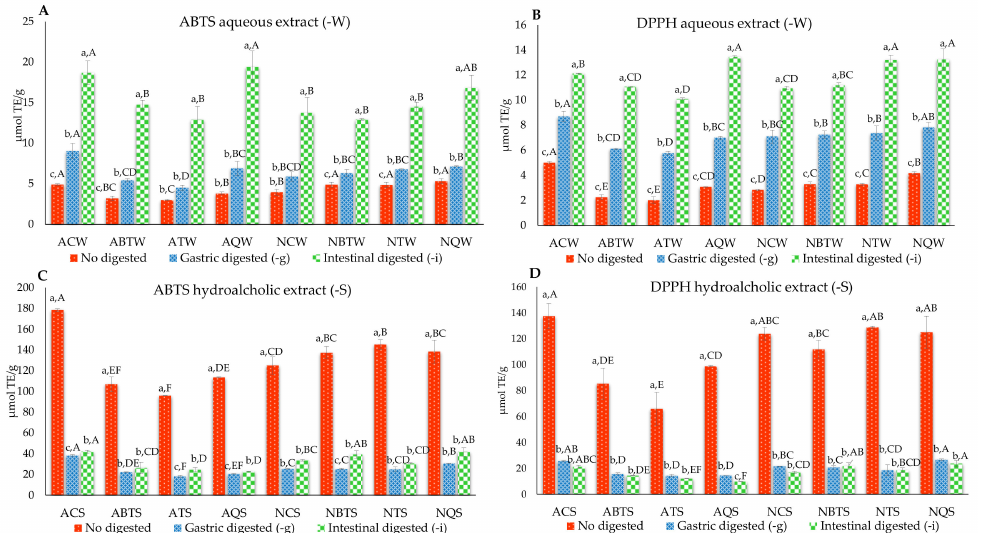
Figure 1. Antioxidant activity of aqueous ( A , B ) and hydroalcoholic ( C , D ) GP extracts before and after simulating the gastric (-g) and intestinal (-i) digestion. Data are expressed as mean values ± standard deviation (SD). Different lower-case letters indicate significant differences among the same extracts versus different samples ( p < 0.05, one-way ANOVA and Tukey’s HSD test). Capital letters indicate a significant difference ( p < 0.05, one-way ANOVA and Tukey’s HSD test) when comparing different GP samples against the same conditions (undigested, gastric-digested, or intestinal-digested). For sample codes, see Table